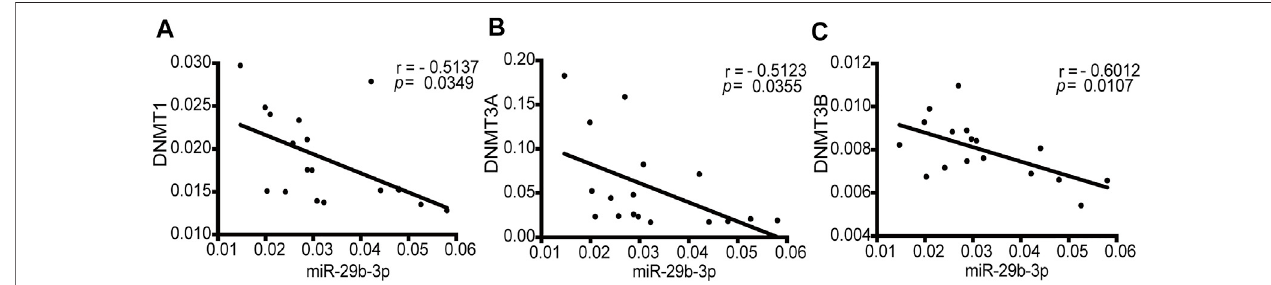
FIGURE 1 | Correlations between the mRNA expression of DNMTs and miR-29b-3p in patients with CHD. (A) The correlation between DNMT1 and miR-29b-3p expression (r = − 0.5137, p = 0.0349). (B) The correlation between DNMT3A and miR-29b-3p expression (r = − 0.5123, p = 0.0355). (C) The correlation between